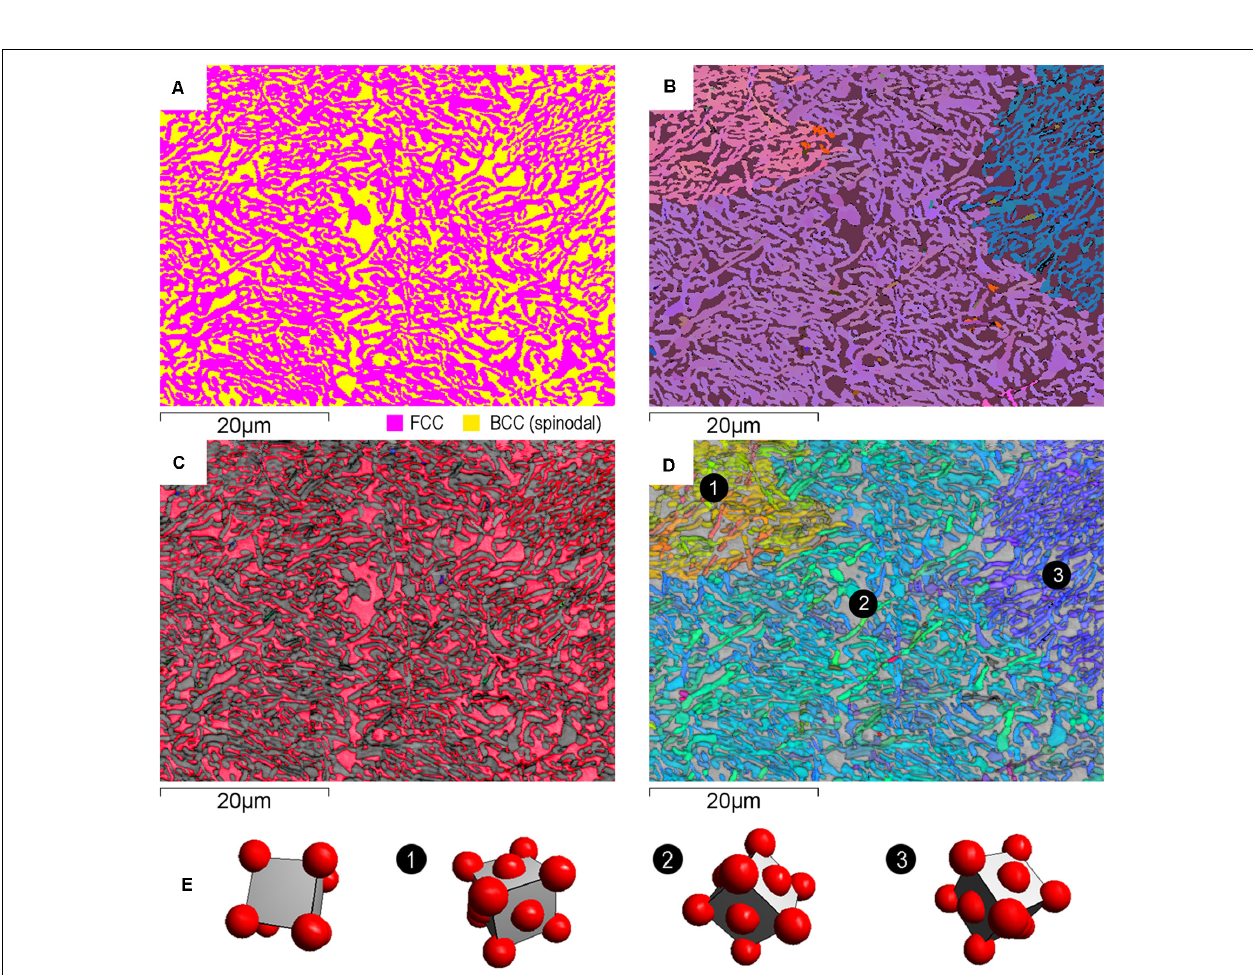
FIGURE 6 | EBSD map in sample AlCrFe 2 Ni 2 with ultrafine vermicular microstructure in a region of interest containing three vermicular domains inside one parent BCC-B2 grain. The phase map (A) reveals the fraction of FCC ∼ 58%. The Euler map (B) outlines the three distinct FCC domains. A better view of the phase orientation is given in the inverse pole figure color maps (C,D) superposed to the pattern quality maps. The crystal mimic of the phases in (E) shows the three FCC variants corresponding to the three vermicular domains. The full crystal OR is listed in Table 3 for each variant.